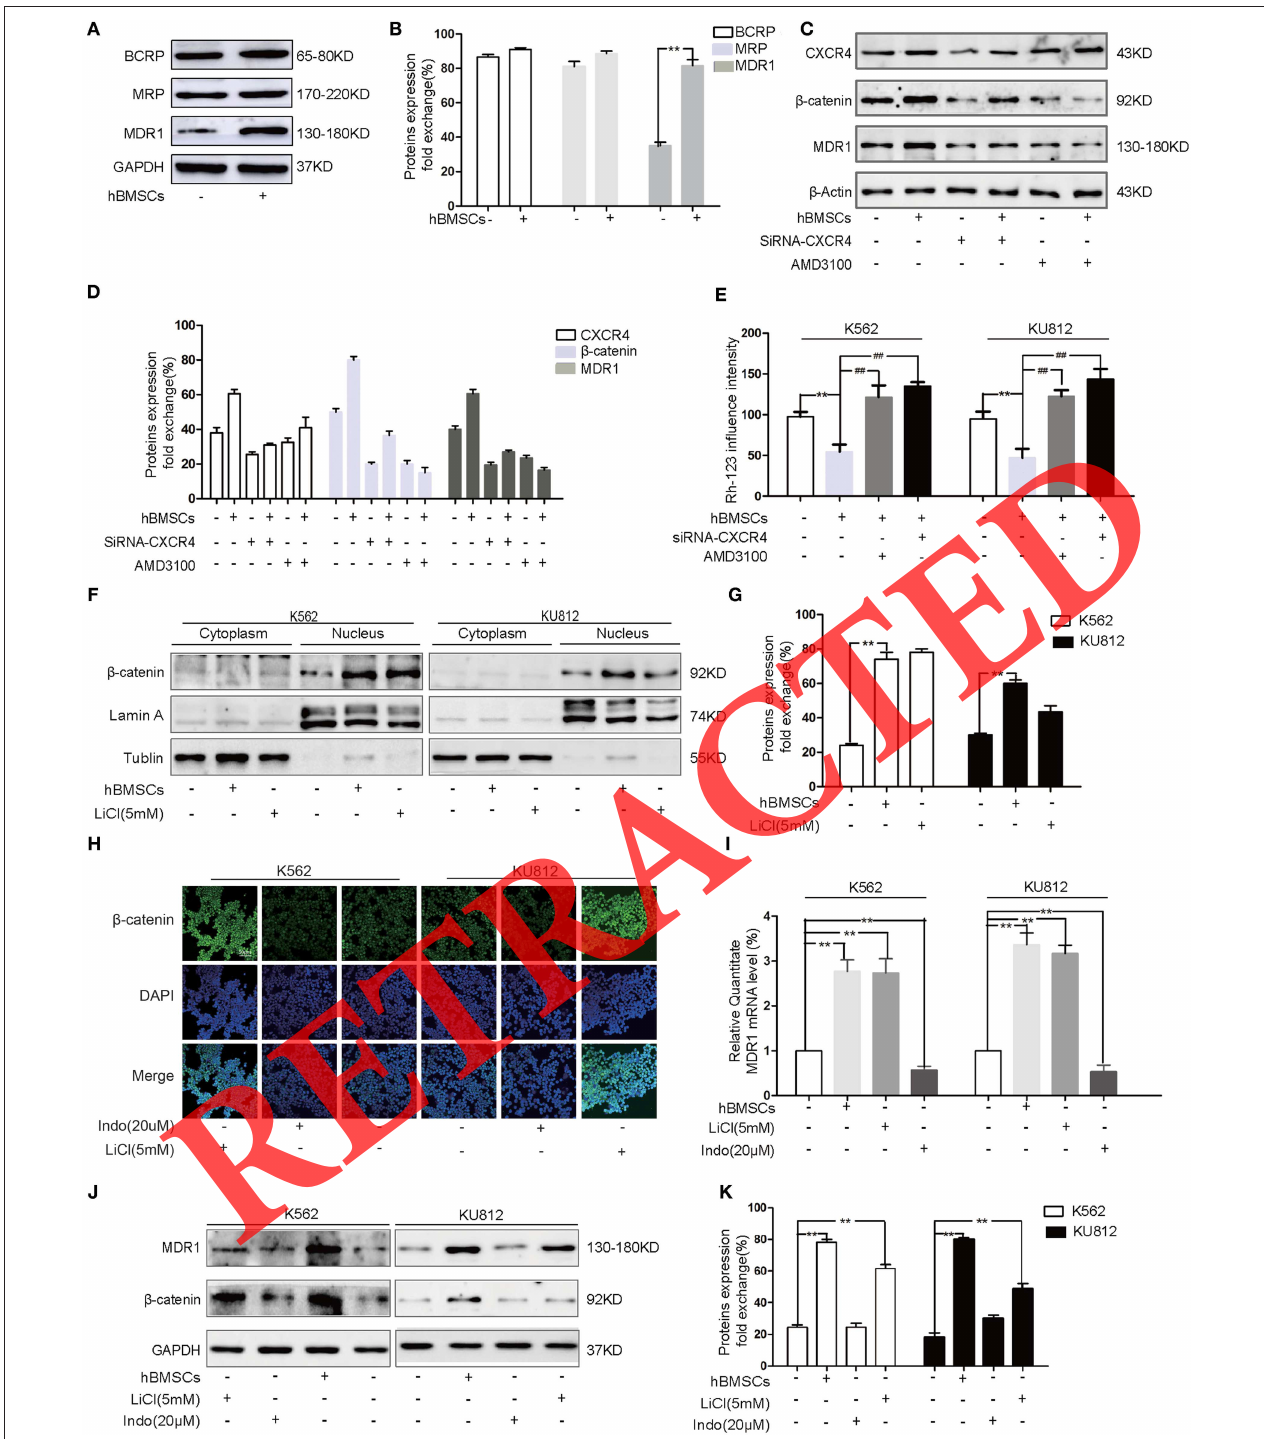
FIGURE 3 | The nuclear-translocation of β -catenin could regulate P-gp. (A) Western blot analysis in K562 cells co-cultured with hBMSCs for 48h. (B) Western blot analysis of BCRP, MRP and P-gp. (C,D) Western blot analysis and (E) Intracellular Rh-123 fluorescence detection after K562 cells being treated with AMD3100 or CXCR4 Si RNA and co-cultured with or without BMSCs. (F,G) Western blot analysis of β -catenin in CML cells in nuclear and cytoplasm, respectively, and (H) immunofluorescence detection of the distribution of β -catenin in K562 and KU812 cells treated with LiCl. MDR1 mRNA and protein expression was detected by (I) RT-PCR assay and (J,K) western blot analysis in K562 and KU812 cells treated with LiCl or 20 µ M Indo. Data (B,E,G,I,K) were shown as Means ± SD for three independent experiments (* p < 0.05, ** p < 0.01, and ## p < 0.01).